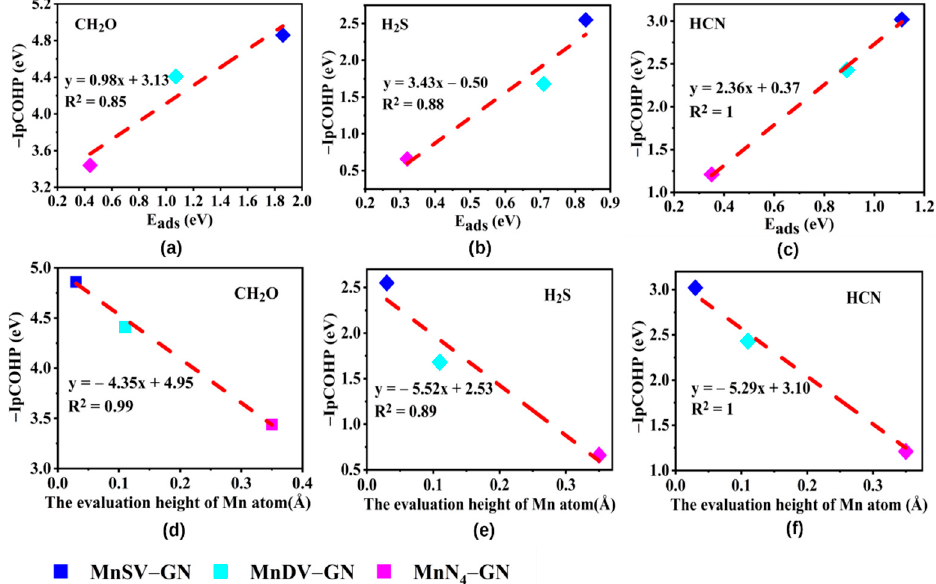
Figure 3. The -IpCOHP values of gases as a function of adsorption energies of ( a ) CH 2 O, ( b ) H 2 S, and ( c ) HCN and Mn atomic heights of ( d ) CH 2 O, ( e ) H 2 S, and ( f )